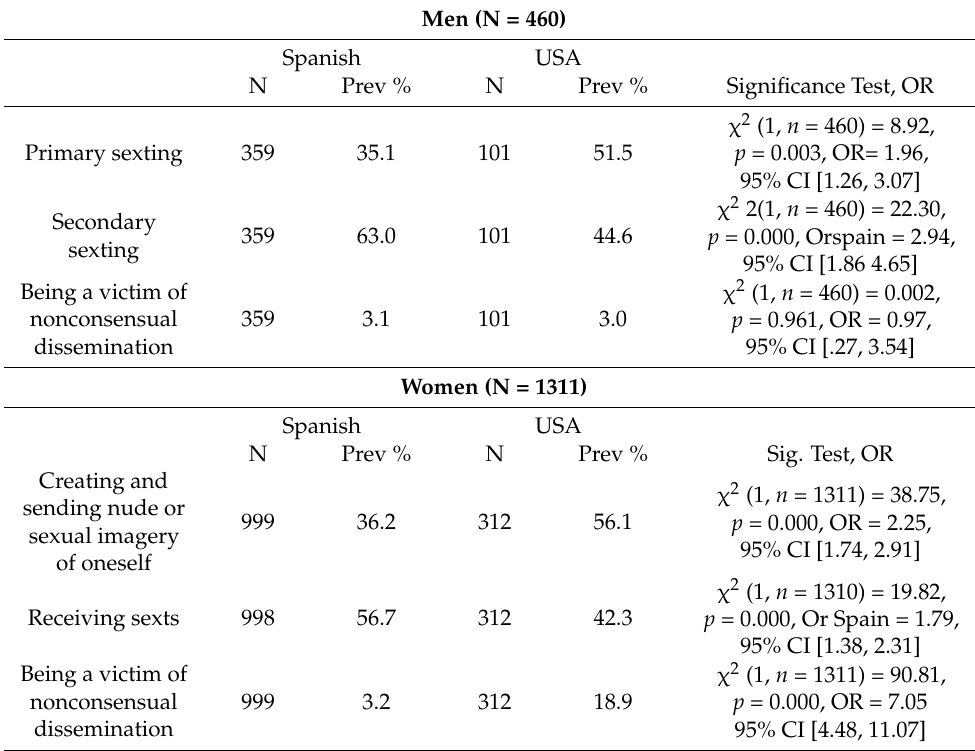
Table 3. Prevalence of sexting behaviors by sex and